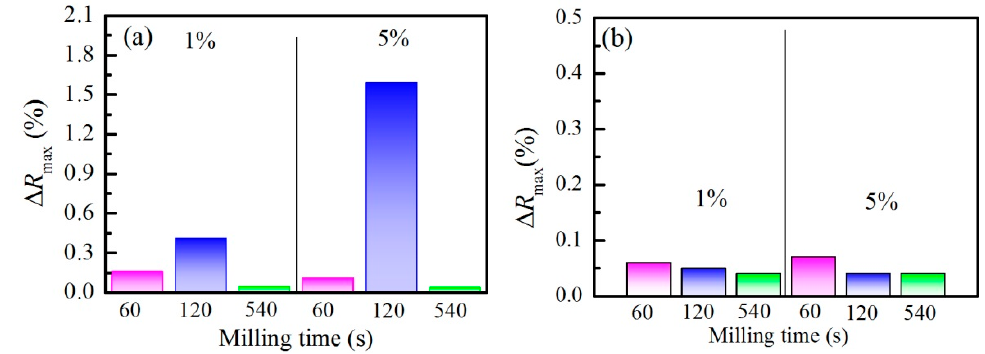
Figure 7. Reflectance change ∆ R max = | R ac/et − R argon | for Nb 2 O 5 -based composite films doped with Na-X fly ash zeolites with different concentrations (denoted on each plot) milled for 60 s (magenta bars), 120 s (blue bars), and 540 s (green bars) and exposed to acetone ( a ) and ethanol ( b ) vapors.